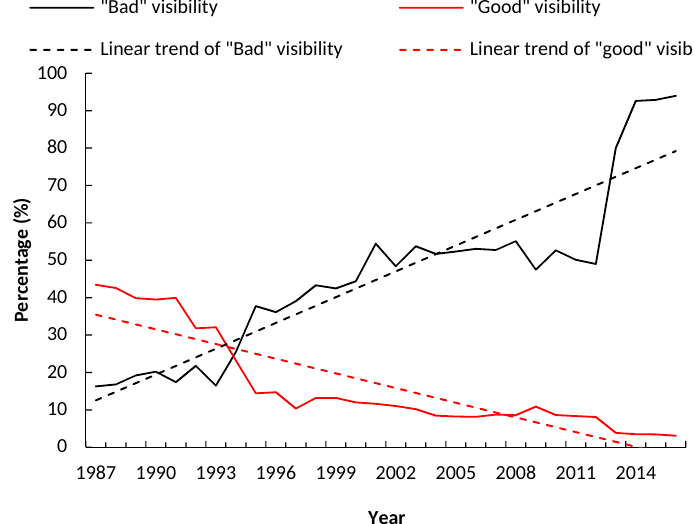
Figure 4. Annual percentages (%) of “bad” atmospheric visibility (<10 km) and “good” visibility ( ≥ 20 km) in Xiamen, during 1987–2016 (dashed lines refer to the curves of linear regression for the corresponding lines of trend.).